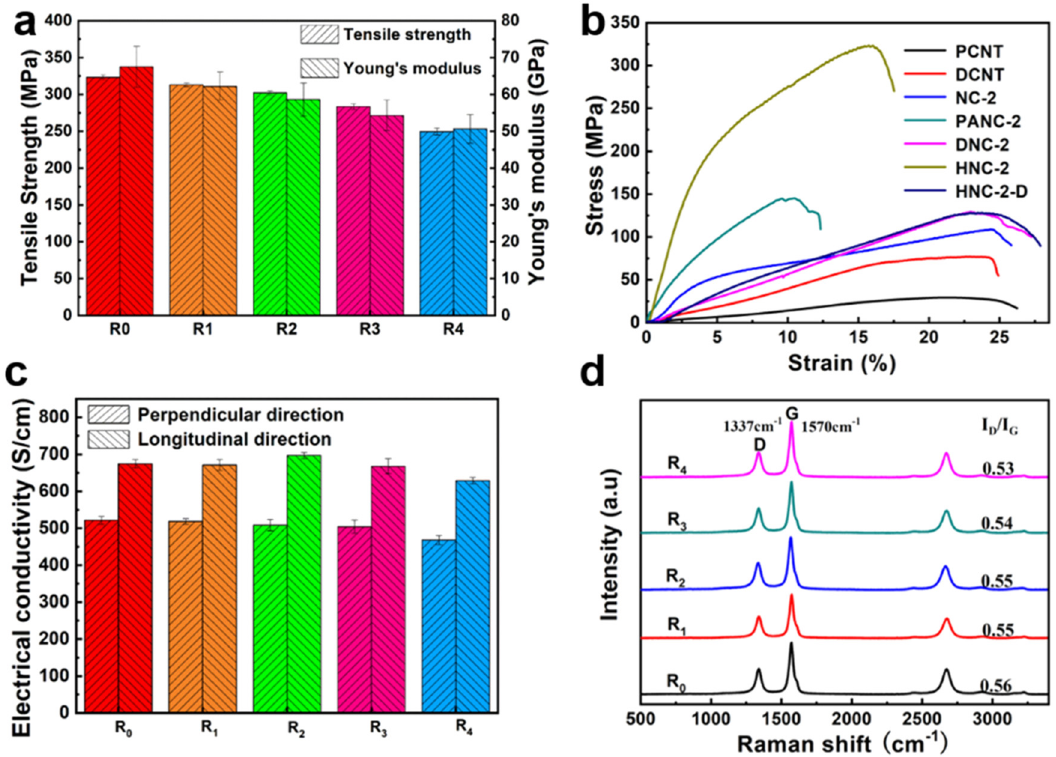
Figure 8: The properties of recovered CNT fi lms functionalized by recycled NC - 2 and HT - BM: ( a ) stress – strain curve of CNT fi lms by di ff erent treatment, ( b ) electrical conductivity, ( c ) tensile strength, and ( d ) Raman